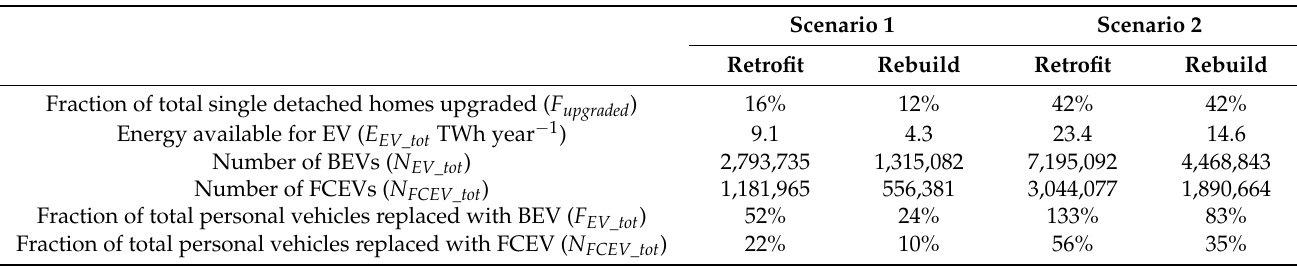
Table 8. Mobility electrification that can be achieved by upgrading enough houses for greenhouse crop production autonomy (scenario 1) and by upgrading all houses that employ electric resistance heating (scenario 2). Scenario 1 Scenario 2 Retrofit Rebuild Retrofit Rebuild Fraction of total single detached homes upgraded ( F upgraded )